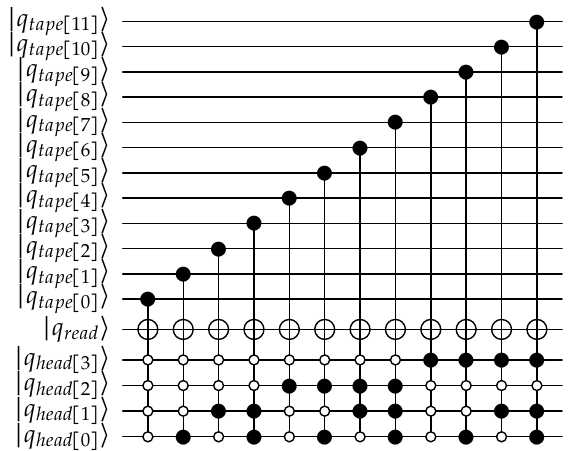
Figure A2. Read tape quantum circuit for QPULBA 2-2-1. Transition table lookup : The transition table encoding is: [ Q t ∣ R Γ ] → [ Q t + 1 ∣ M l / r ∣ W Γ ] . The transition function circuit is shown in Figure A3.